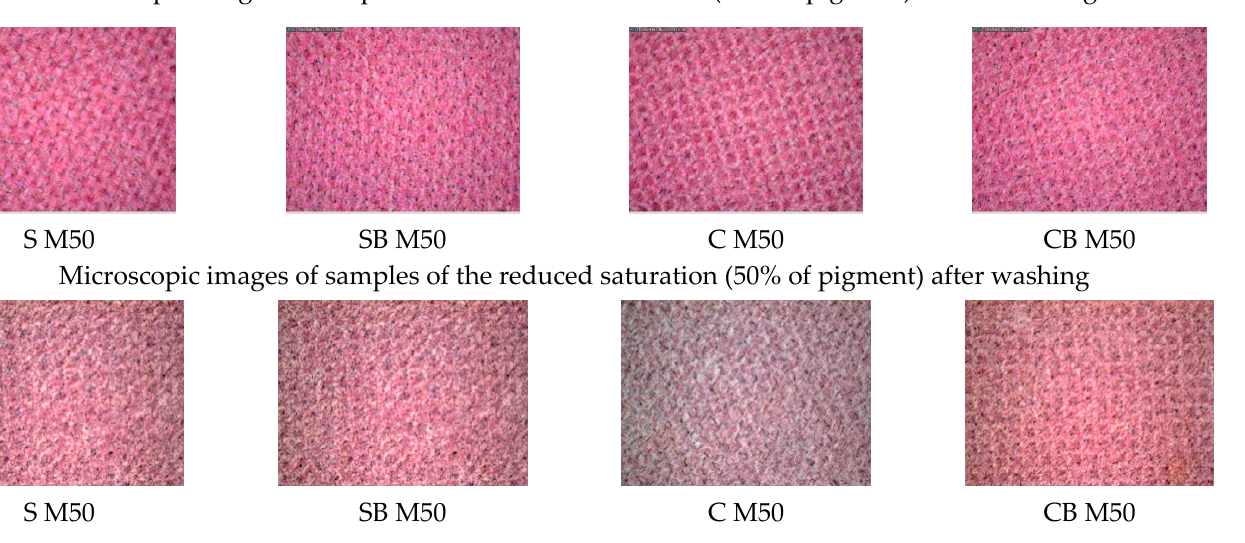
Figure 6. Microscopic images of samples printed in magenta colour hue, before and after the 10th washing cycle.